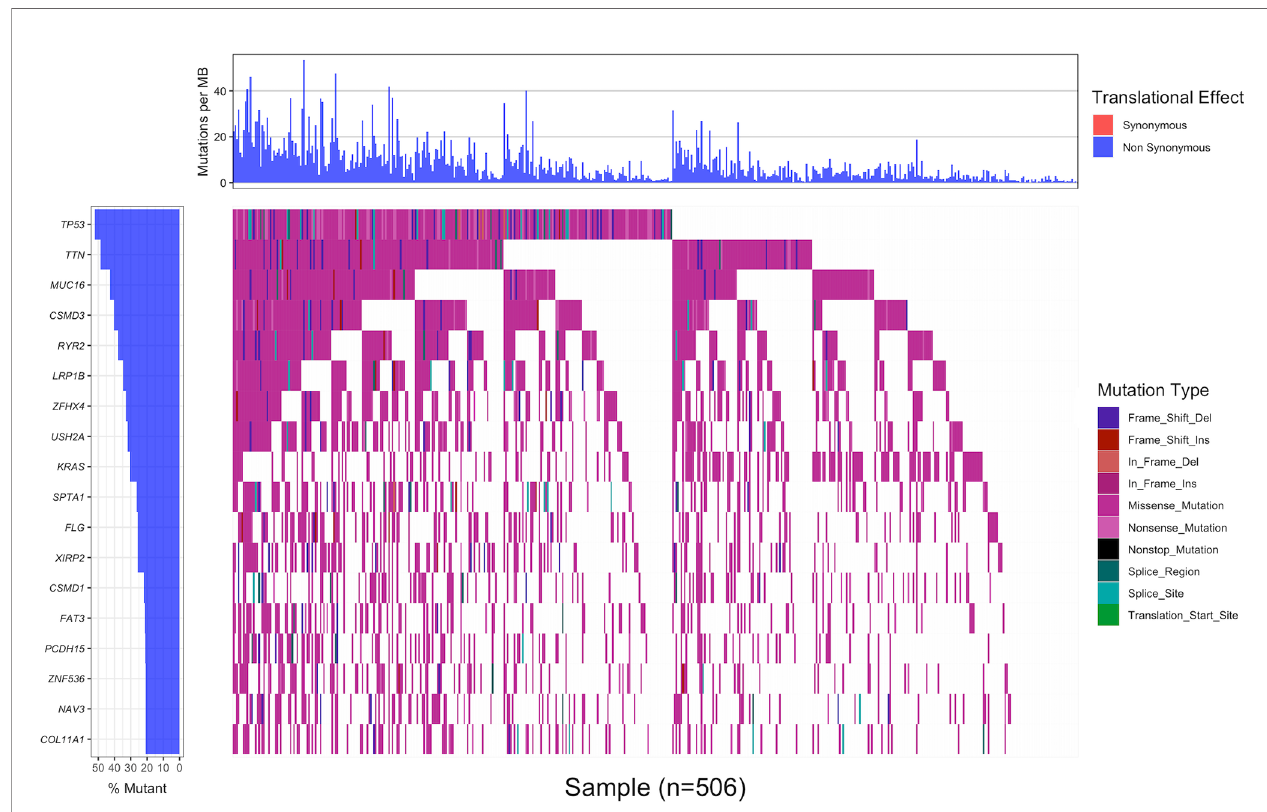
FIGURE 1 | The waterfall plot displaying the landscape of frequently mutated genes in 506 LUAD samples with non-synonymous mutation frequency in the coding region greater than 20%. Genes were arranged in descending order of mutation frequency (left panel), and different colors represented different mutation types (right panel). The upper panel indicated the number of non-synonymous mutations in the coding region per Mb of each